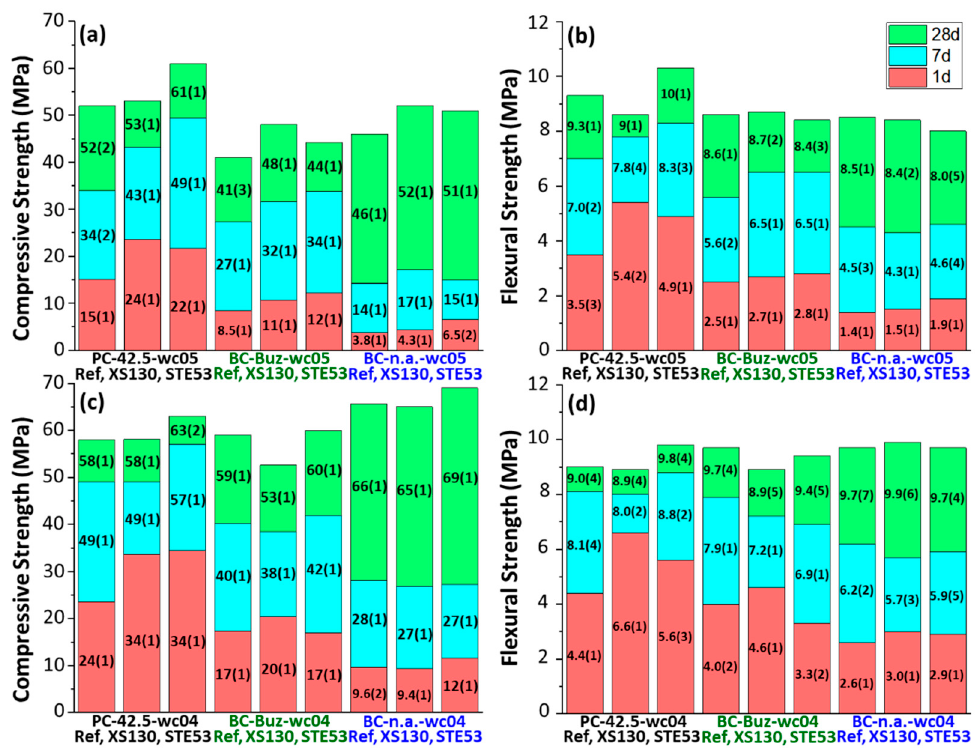
Figure 1. Mechanical strength results for the eighteen studied mortars at 1, 7, and 28 days of hydration. Compressive strengths (left panels: ( a , c )). Flexural strengths (right panels: ( b , d )).